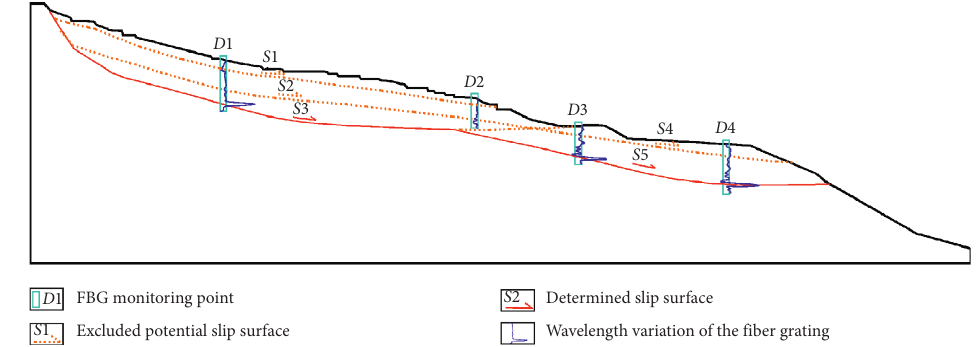
Figure 14: Cross-section of the monitoring of internal deformation for the Toudu landslide.